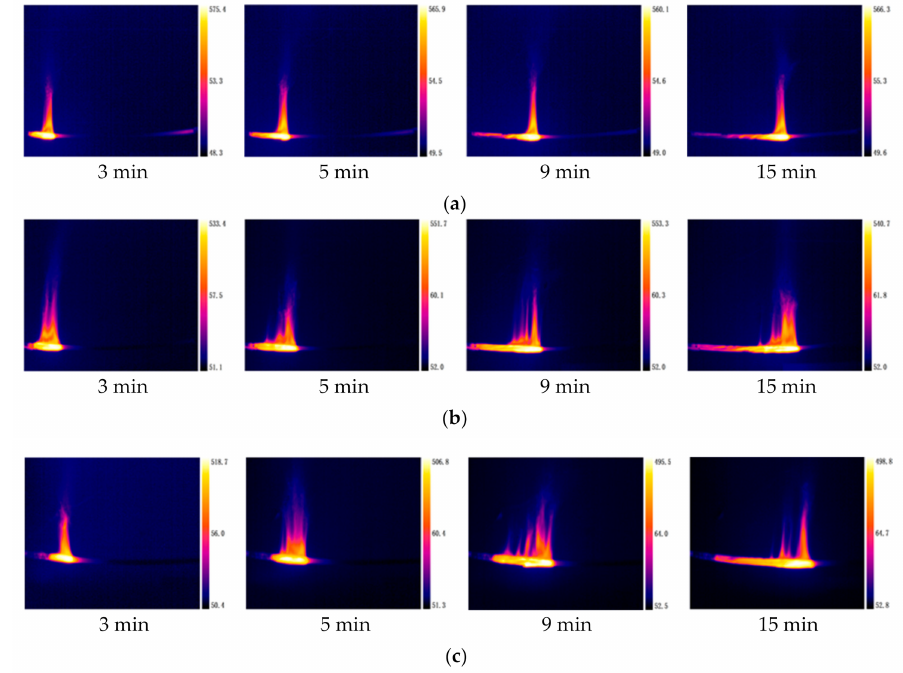
Figure 14. Temperature distribution of multiple cables with di ff erent cable number at di ff erent time. ( a ) Single cable; ( b ) two cables; ( c ) three